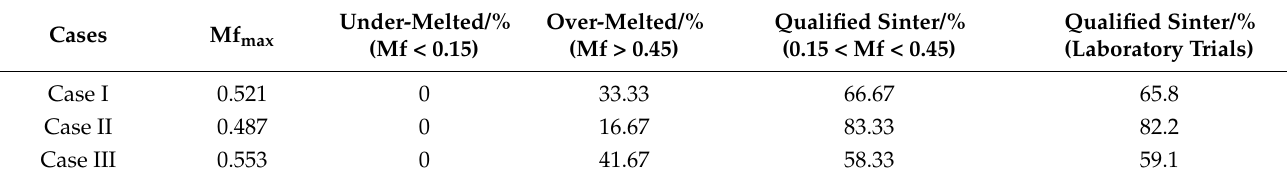
Table 7. Analysis of Mf for case I, II and